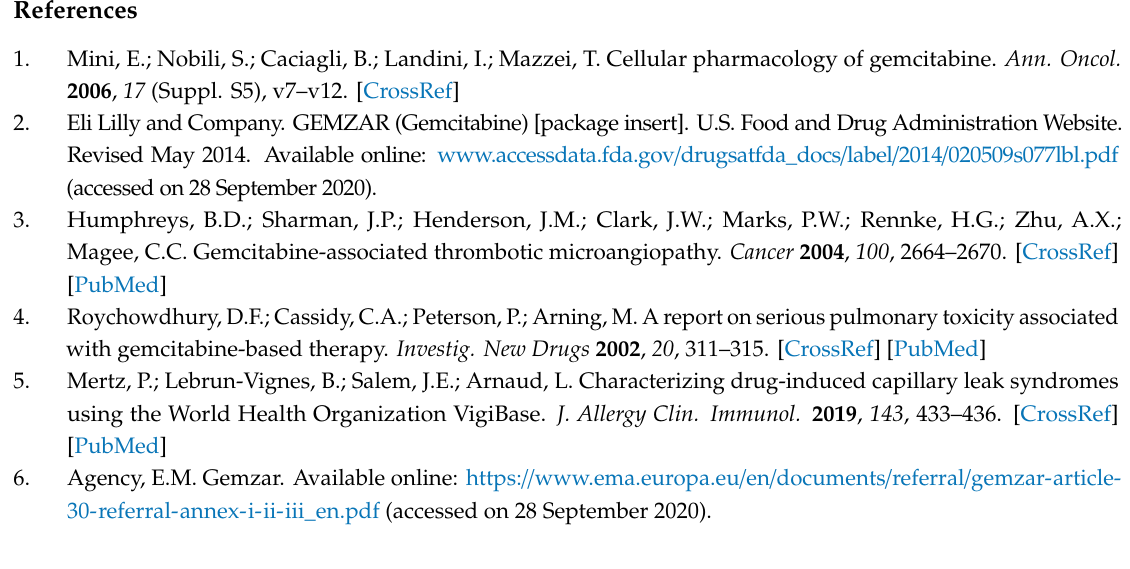
Figure S1: Summary of one of our case-report presenting a capillary leak syndrome associated with gemcitabine reversible after glucocorticoids, Figure S2: Flowchart of selected studies to describe cardiovascular adverse events associated with gemcitabine, Figure S3: UpsetR graph representing overlap between cardiovascular sub-classifications, Table S1: Concurrent adverse events in individual case safety reports of gemcitabine-associated cardiovascular adverse drug reactions (CV-ADRs) in VigiBase, Video S1: Echocardiography at admission, Video S2: Echocardiography at day 5, Video S3: Echocardiography at admission at day